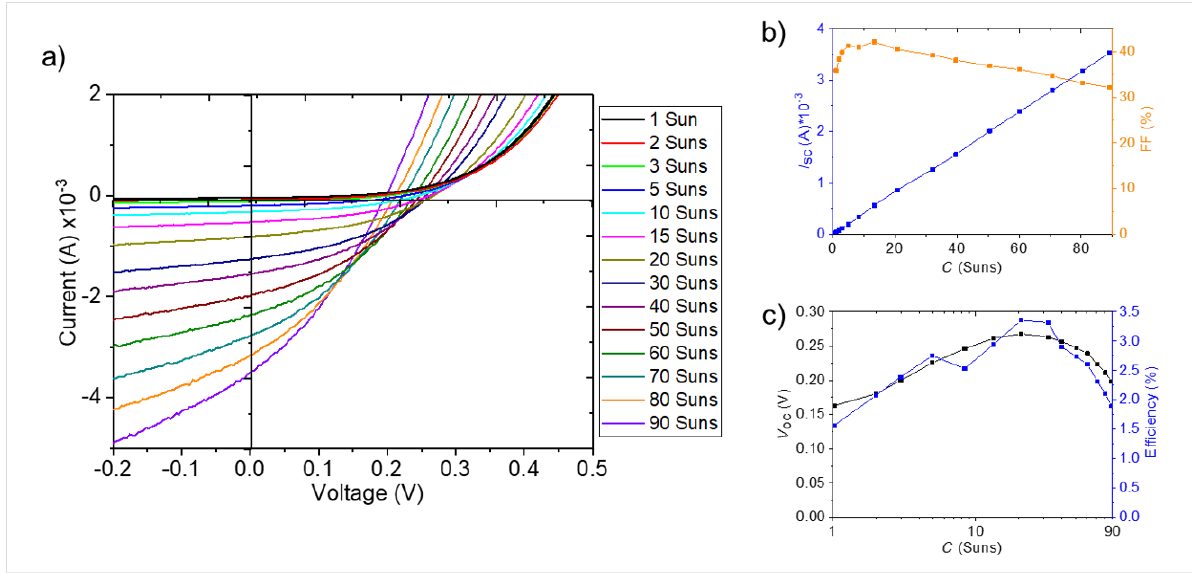
Figure 15: Electrical characterization under various light concentration factors for CIGSe micro cell from nucleation approach: a) IV curves, b) I SC and FF, c) V OC and η .